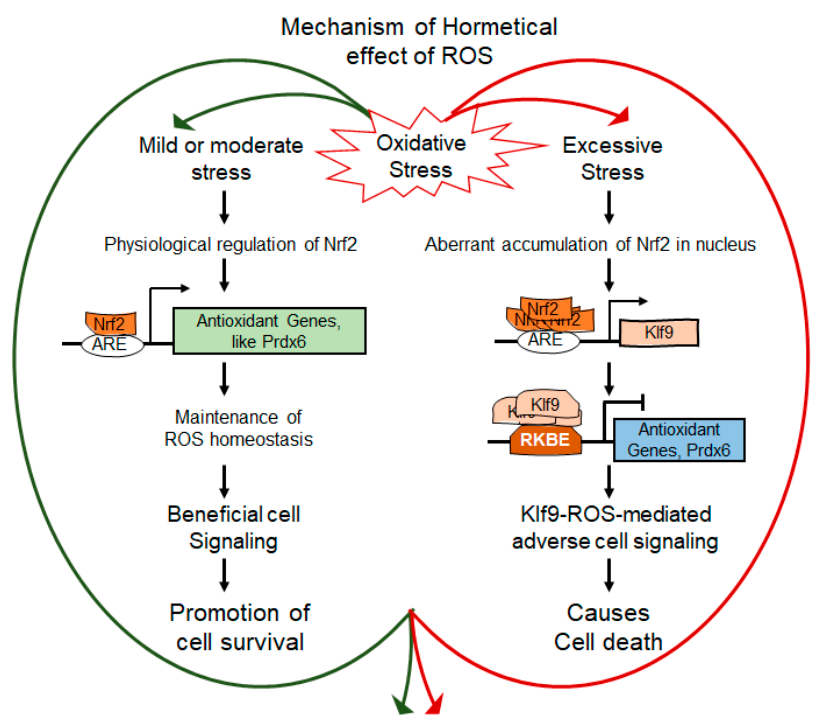
Figure 12. Diagrammatic Illustration of the molecular mechanism governing the bimodal effect of ROS responsible for cellular response in response to oxidative stress. Mild to moderate oxidative stress regulates the Nrf2 at physiological level while excessive oxidative stress aberrantly accumulates the Nrf2 into nucleus. Physiological regulations of Nrf2 activates its target antioxidant genes transcription and expression by binding to antioxidant response element (ARE) sites present in the regulatory region of antioxidant genes and maintain the cellular ROS homeostasis which leads to beneficial cell signaling. At higher levels of oxidative stress, aberrant accumulations of Nrf2 in nucleus, paradoxically activated Klf9 transcription by binding to its ARE sites present in Klf9 gene promoter, and this aberrant Klf9 expression repressed some of the antioxidant genes, such as Prdx6. Finally, these phenomena result in Klf9 abundance-dependent increased ROS amplification, and subsequent cell injuries/death at least in part by transcriptional suppression of Prdx6. Taken together, our data demonstrate that Nrf2-Klf9-Prdx6-axis can play a role in determining ROS-mediated signaling pathway and biological response(s) in conditions of oxidative stress.